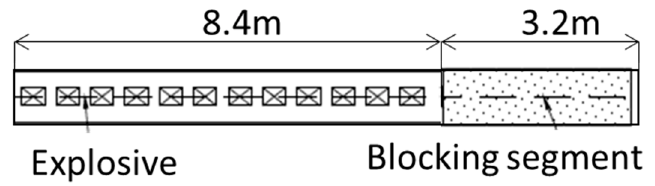
Figure 17. The structure of the single-hole charge.